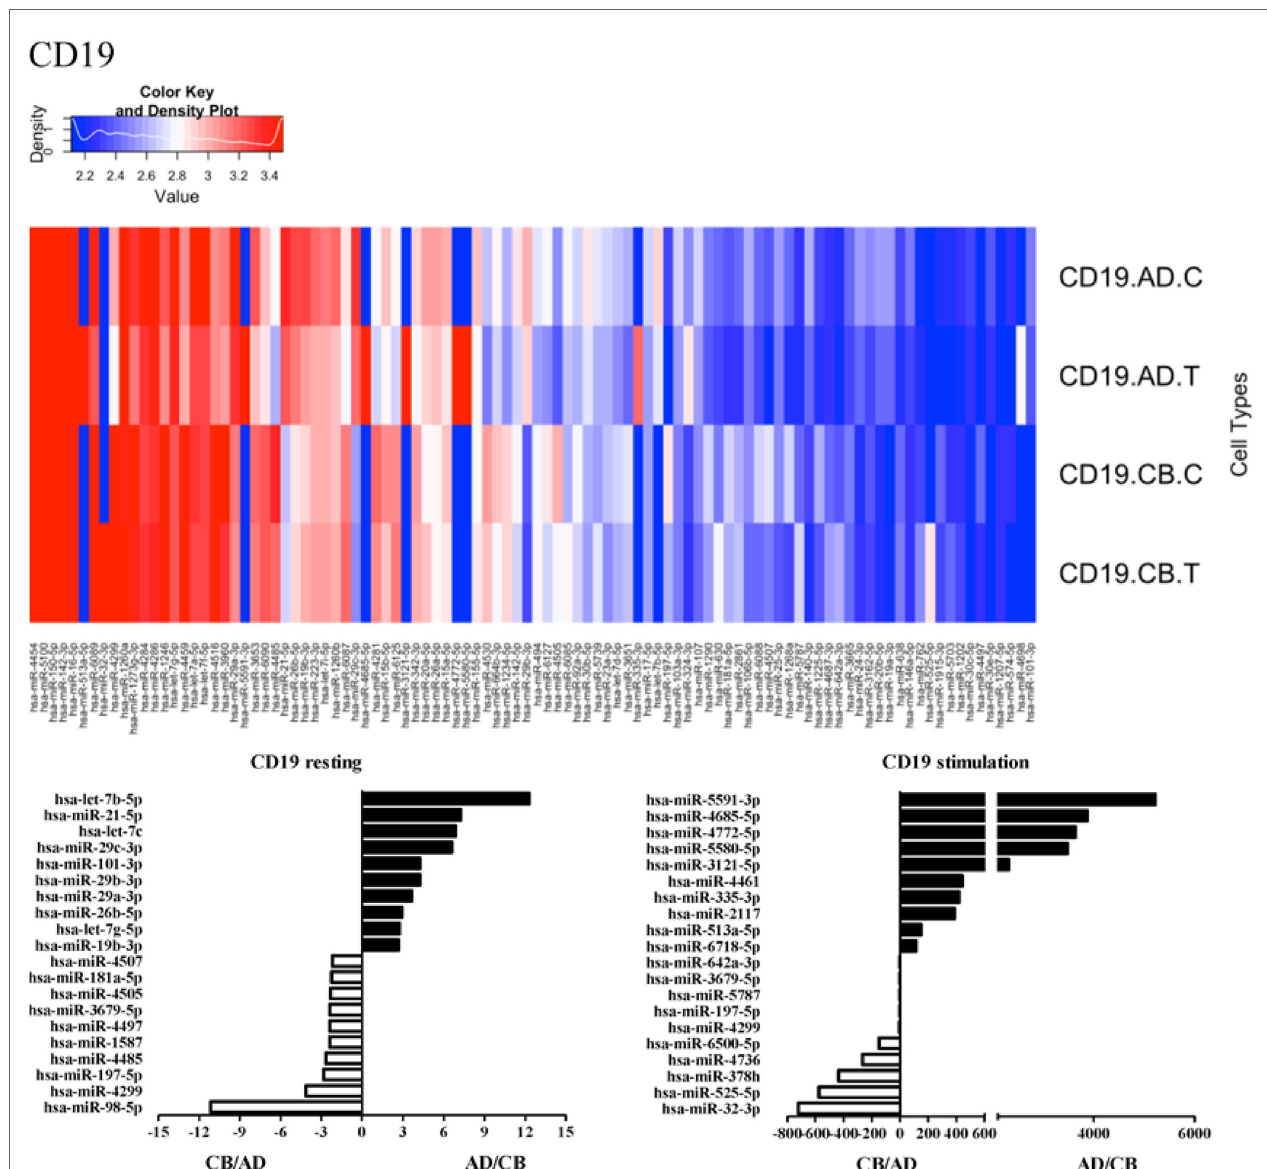
FigUre 7 | Differential microrna profiles between adult and neonatal cD19 + B-cells